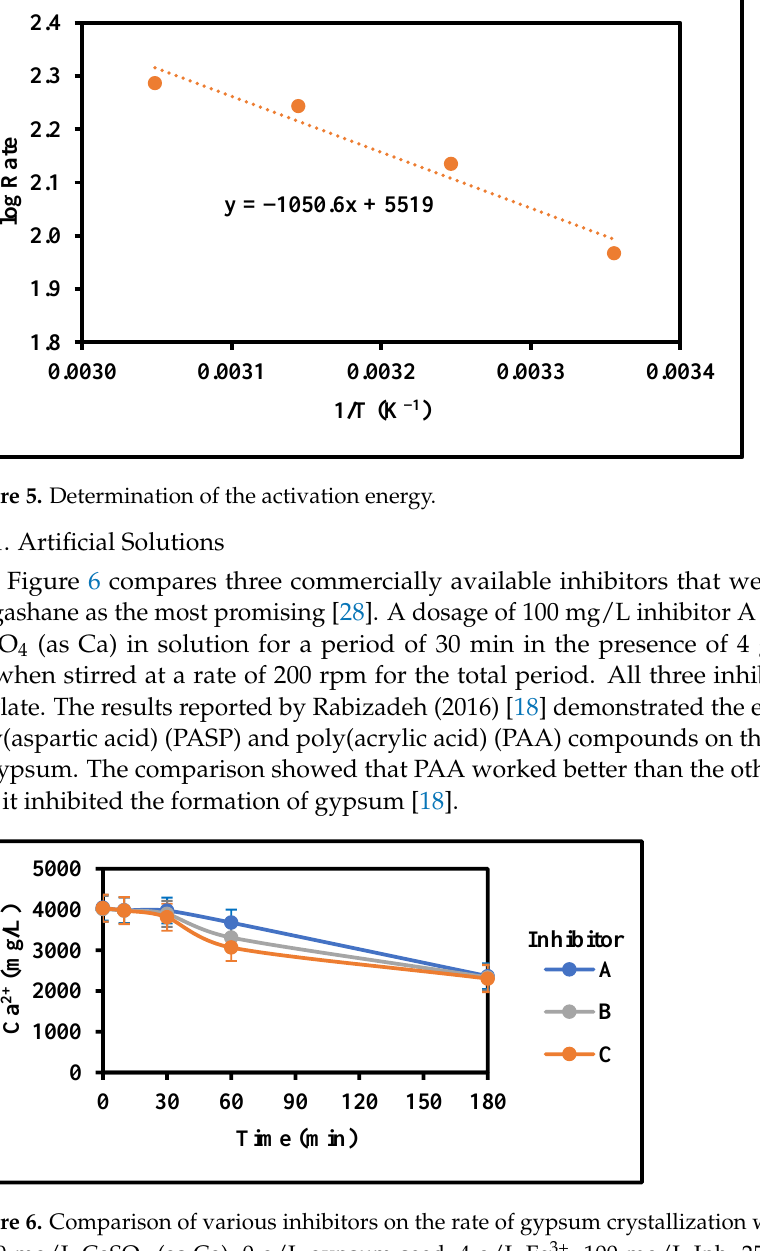
Figure 4. Effect of temperature on the rate of gypsum crystallization (3000 mg/L CaSO 4 (as Ca), 5 g/L gypsum seed, 0 g/L Fe 3+ , 0 mg/L Inh, 25 – 55 °C, stirring rate: 200 rpm; Stirring time (min): 180/180).